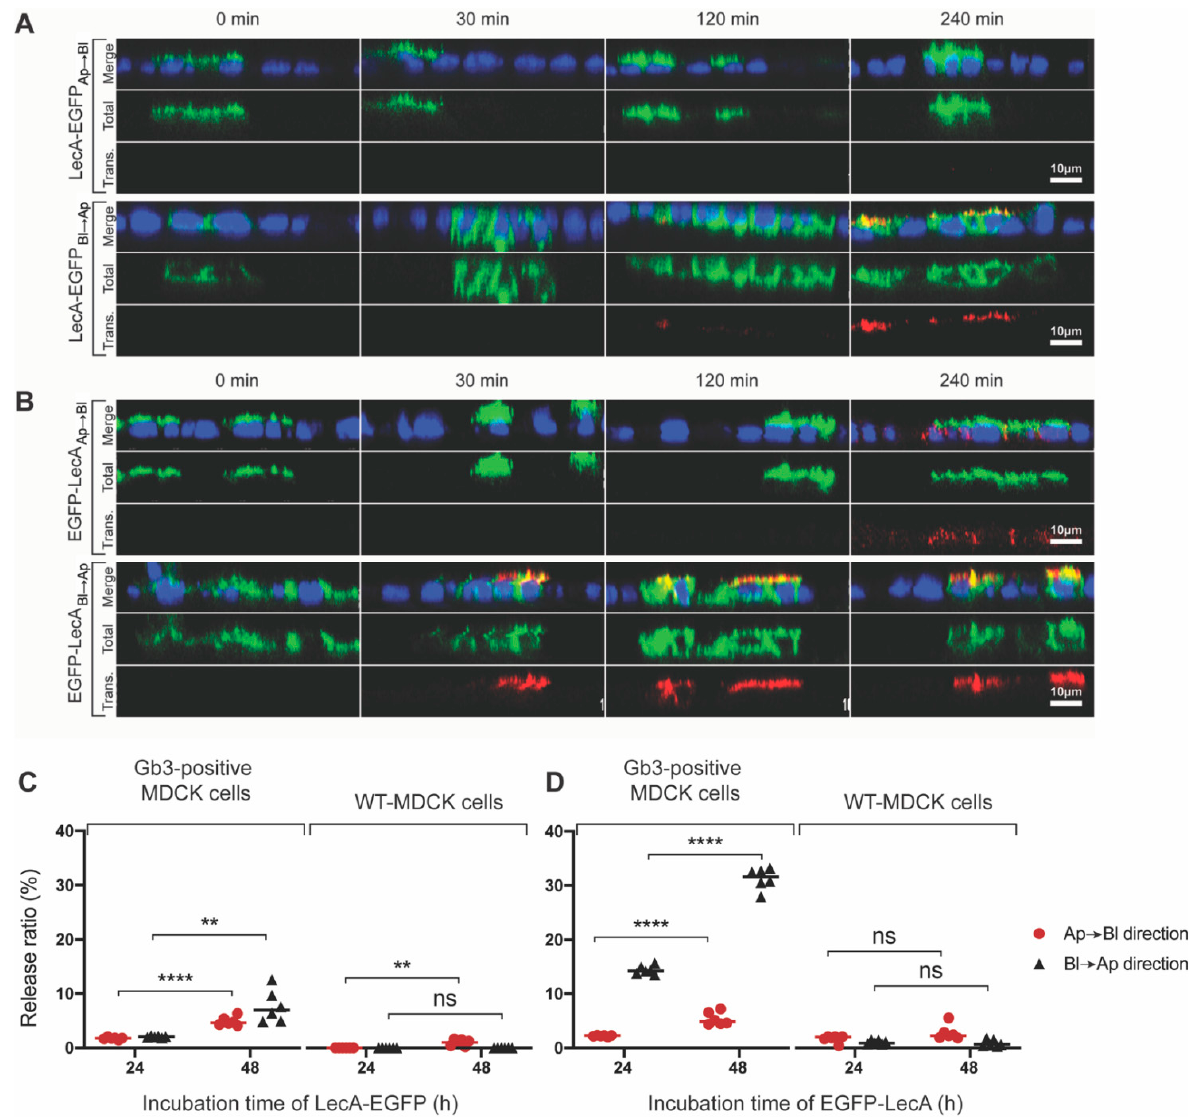
Figure 6. Transcytosis of LecA-fusion proteins. ( A ) Transcytosis of LecA-EGFP (green) in Gb3-positive MDCK cells illustrated by immunofluorescence. Firstly, LecA-EGFP was added either to the Ap or Bl cell surface and incubated at 4°C for 30 min. Then, cells were shifted to 37 °C for up to 240 min without further washing steps. Afterward, a primary antibody toward LecA was incubated at 4 °C to detect LecA-EGFP on the opposite side. A secondary antibody with AF647 (red) was used to detect the primary antibody toward LecA. ( B ) The transcytosis of EGFP-LecA (green) in Gb3-positive MDCK cells was illustrated by immunofluorescence. EGFP-LecA was pre-bound to the Ap or Bl cell surface at 4 °C for 30 min. Afterward, cells were incubated at 37 °C for the indicated time points without further washing steps. A primary antibody toward LecA was used at 4 °C for the detection of EGFP-LecA on the opposite side. A secondary antibody with AF647 (red) was used to detect the primary antibody of LecA. ( A , B ) Representative cross-sections of acquired z-stack images are shown (scale bar: 10 µm). ( C , D ) The release ratios of LecA-EGFP ( C ) and EGFP-LecA ( D ) were measured after 24 and 48 h of medium-to-medium transcytosis based on EGFP fluorescence by using a microplate reader. The release ratios were measured from two monolayers composed of either Gb3-positive MDCK cells or WT-MDCK cells. The unpaired Student’s t -test was used to calculate the significant differences between groups. Mean values are shown. ** p < 0.01; **** p < 0.0001; ns, not significant. For each time point, the included sample number n was equal to 6.